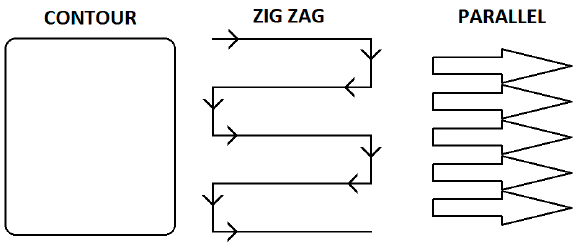
Figure 2. Sketches of type of strategies applied.